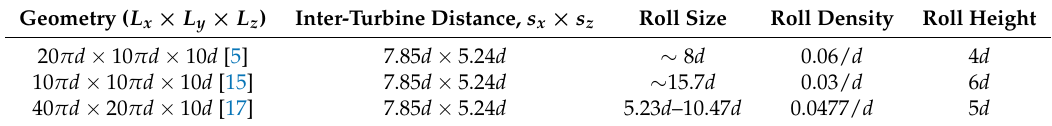
Table 3. Roll features in POD computation of the periodic wind farms, d = 0.1 H . Roll-size denotes spanwise extent from center to center of roll vortices (zero crossing of streamwise modes). Roll density is number of roll pairs/ L y . Roll-height—height of the center of roll-vortices above ground. Geometry ( L x × L y × L z